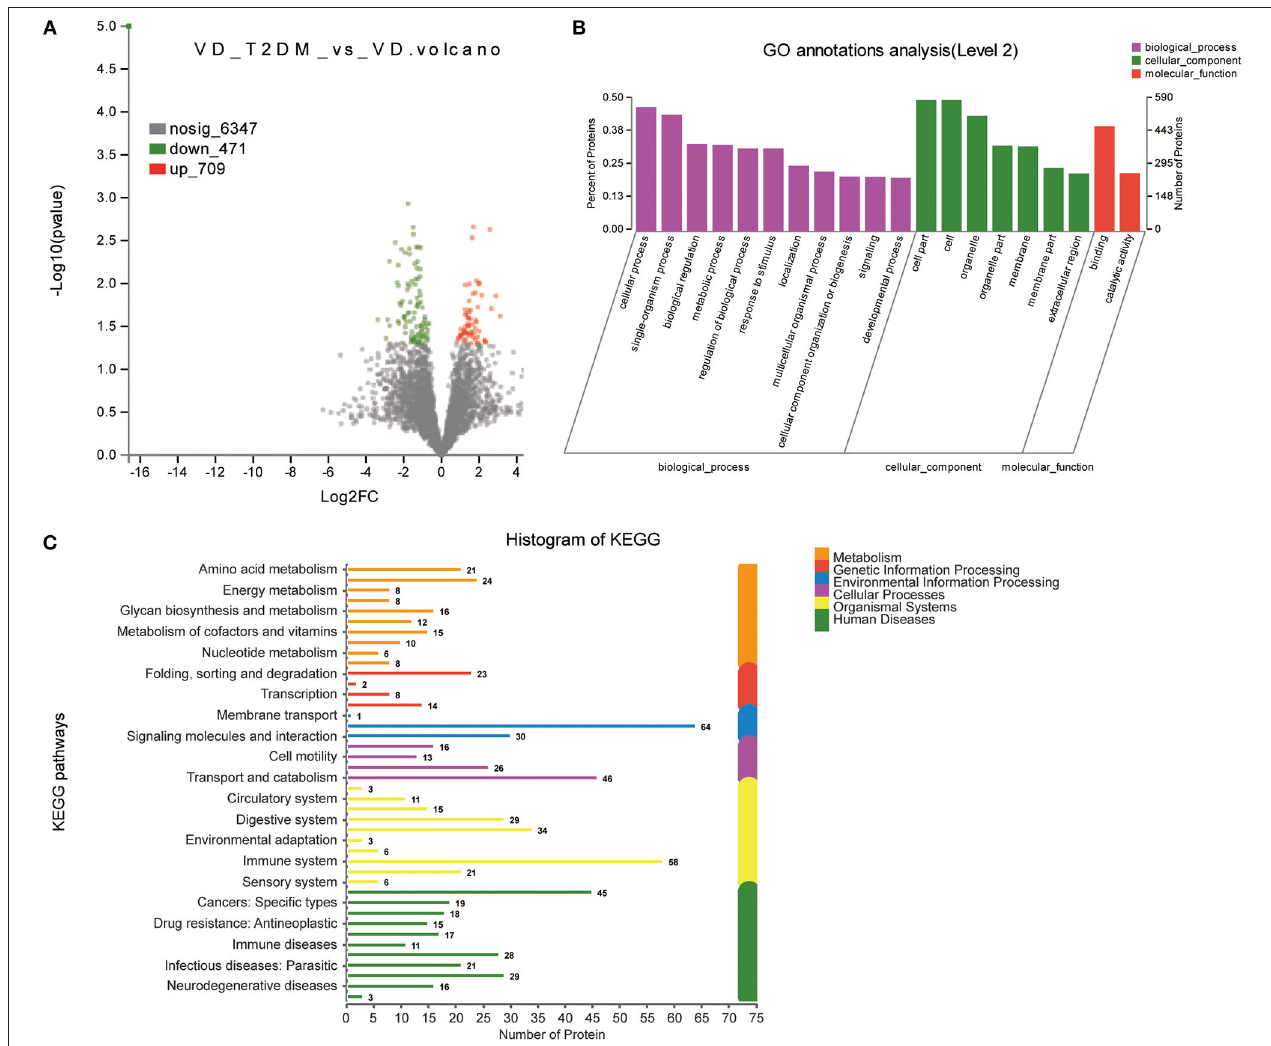
FIGURE 5 | Volcano plots of quantified proteins and functional analysis of DEPs in the urine between subjects with VD + T2DM and VD (notes same as Figures 1 – 3